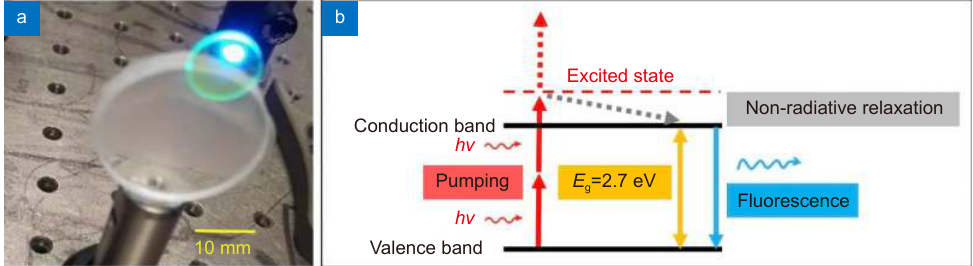
Fig. 7 | ( a ) Fluorescence of polycrystalline ZnSe pumped at 775 nm. ( b ) Illustration of the two-photon absorption and fast relaxation to the top of the conduction band followed by spontaneous emission to the valence